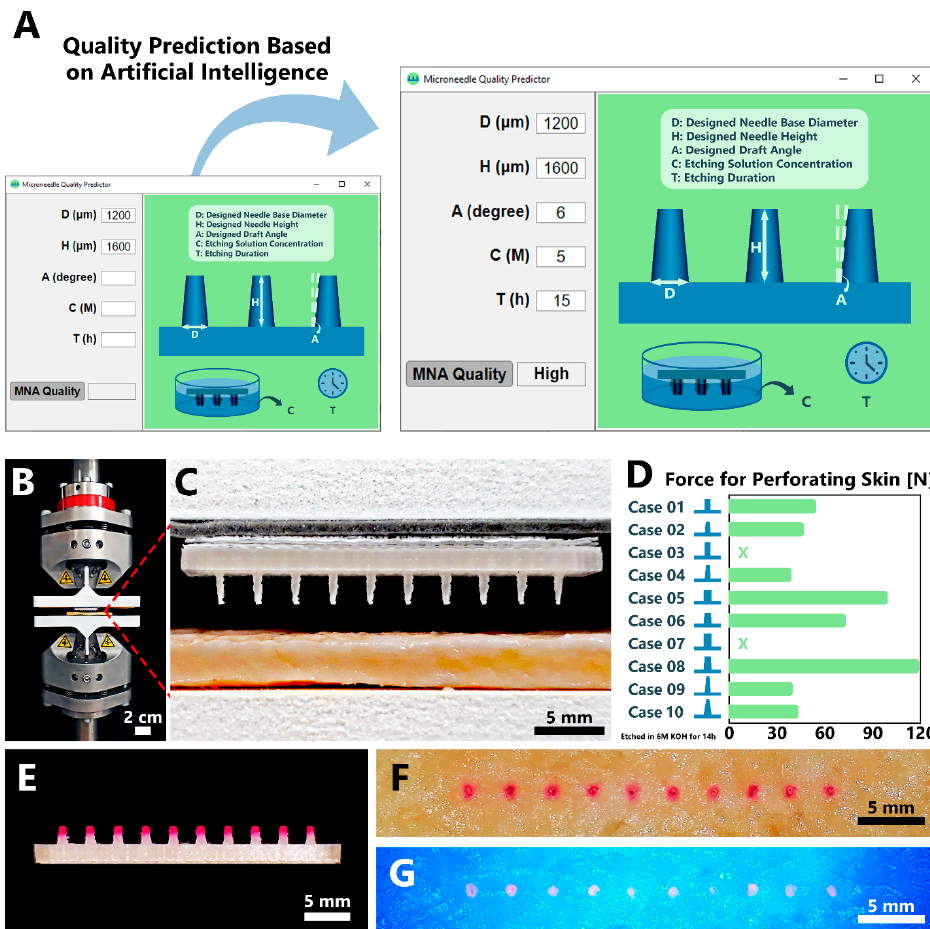
Figure 5. Developed GUI for MNA quality prediction, and capability of MNAs for perforation of porcine skin ex vivo. ( A ) A GUI was developed to predict the quality of the fabricated MNs based on the geometric and etching features input. The core of the GUI was based on the developed ML model, with addition of upper and lower limits for the input parameters (i.e., GUI rejects any input parameter that is out of its determined logical range). The user can enter the five parameters they intend to utilize for fabrications of MNAs, and upon clicking the button “MNA Quality”, the predicted quality of the MNA will be displayed next to the button as “High” or “Low”. ( B ) Using custom 3D-printed holders, ( C ) the skin sample was placed on the lower holder and the MNA was bonded to the upper holder. The device moved these holders towards each other until the MNs were inside the skin while ( D ) the required force [N] value for perforation of the skin was measured precisely for all of the geometrical specifications offered in Table 1. The MNAs used in this experiment were etched in 6 M KOH solution for 14 h. X: The MNA was not able to perforate the skin sample and broke under the increasing force. ( E ) In order to show the capability of the prepared MNAs for delivery of RhB as a model drug, tips of an example MNA (case 6 in Table 1, featuring a designed based diameter and height of 1500 µ m and 2000 µ m, respectively, and draft angle of 5 ◦ , etched in a 5 M KOH solution for 14 h) were coated with aqueous solution of starch and RhB mixture and were inserted into the porcine skin. The insertion and perforation sites are presented ( F ) under visible light, and ( G ) under UV